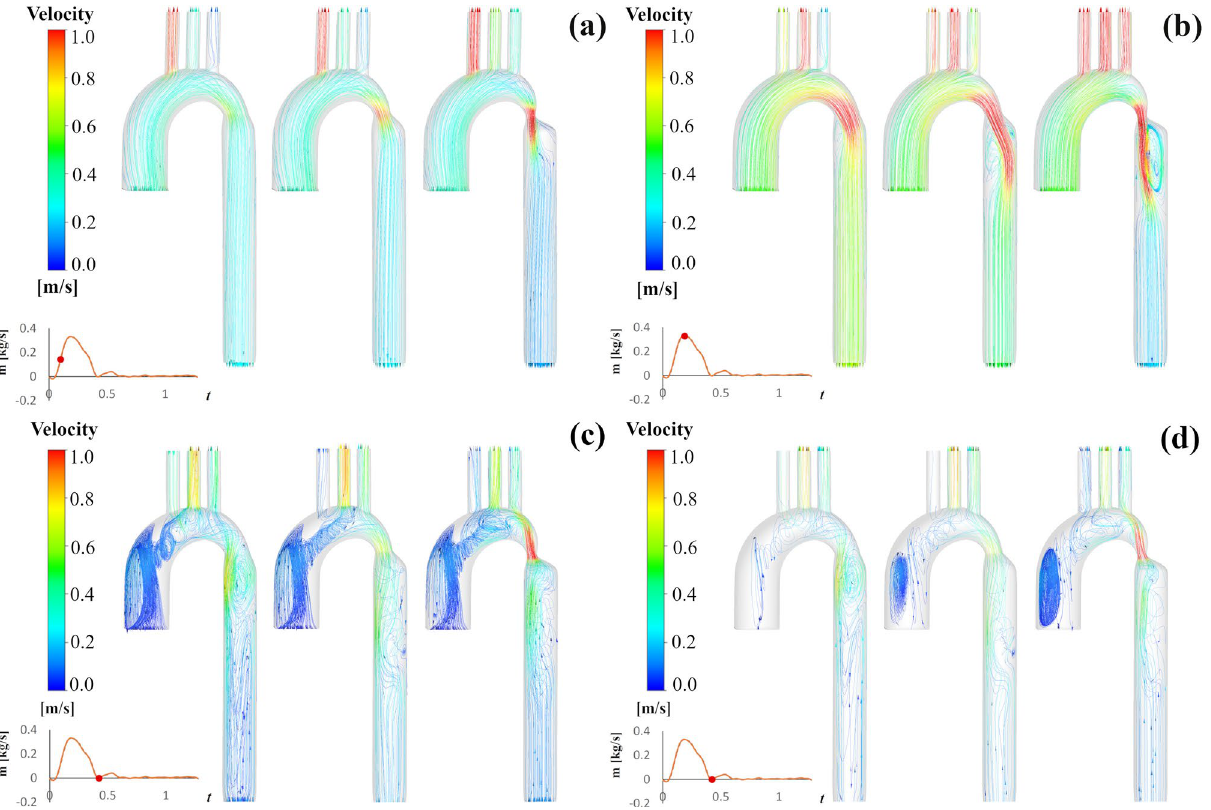
Figure 3. Streamlines in the right anterior view at ( a ) mid-systole, ( b ) peak systole, and ( c ) dicrotic notch; ( d ) Backward flow during dicrotic notch (left: 25% coarctation, middle: 50% coarctation, right: 75%